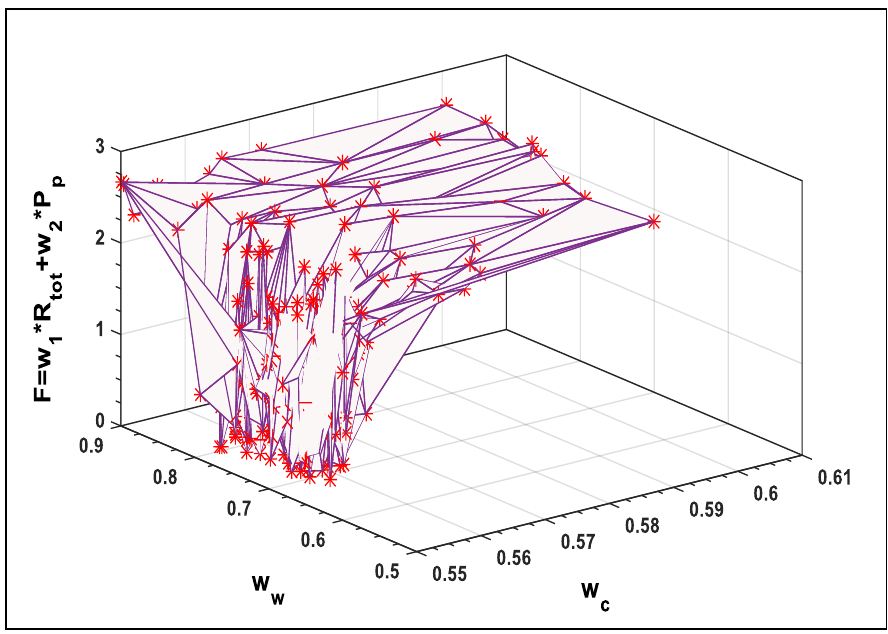
Figure 8. Effect of w w and w c on F. Figure 8. Effect of